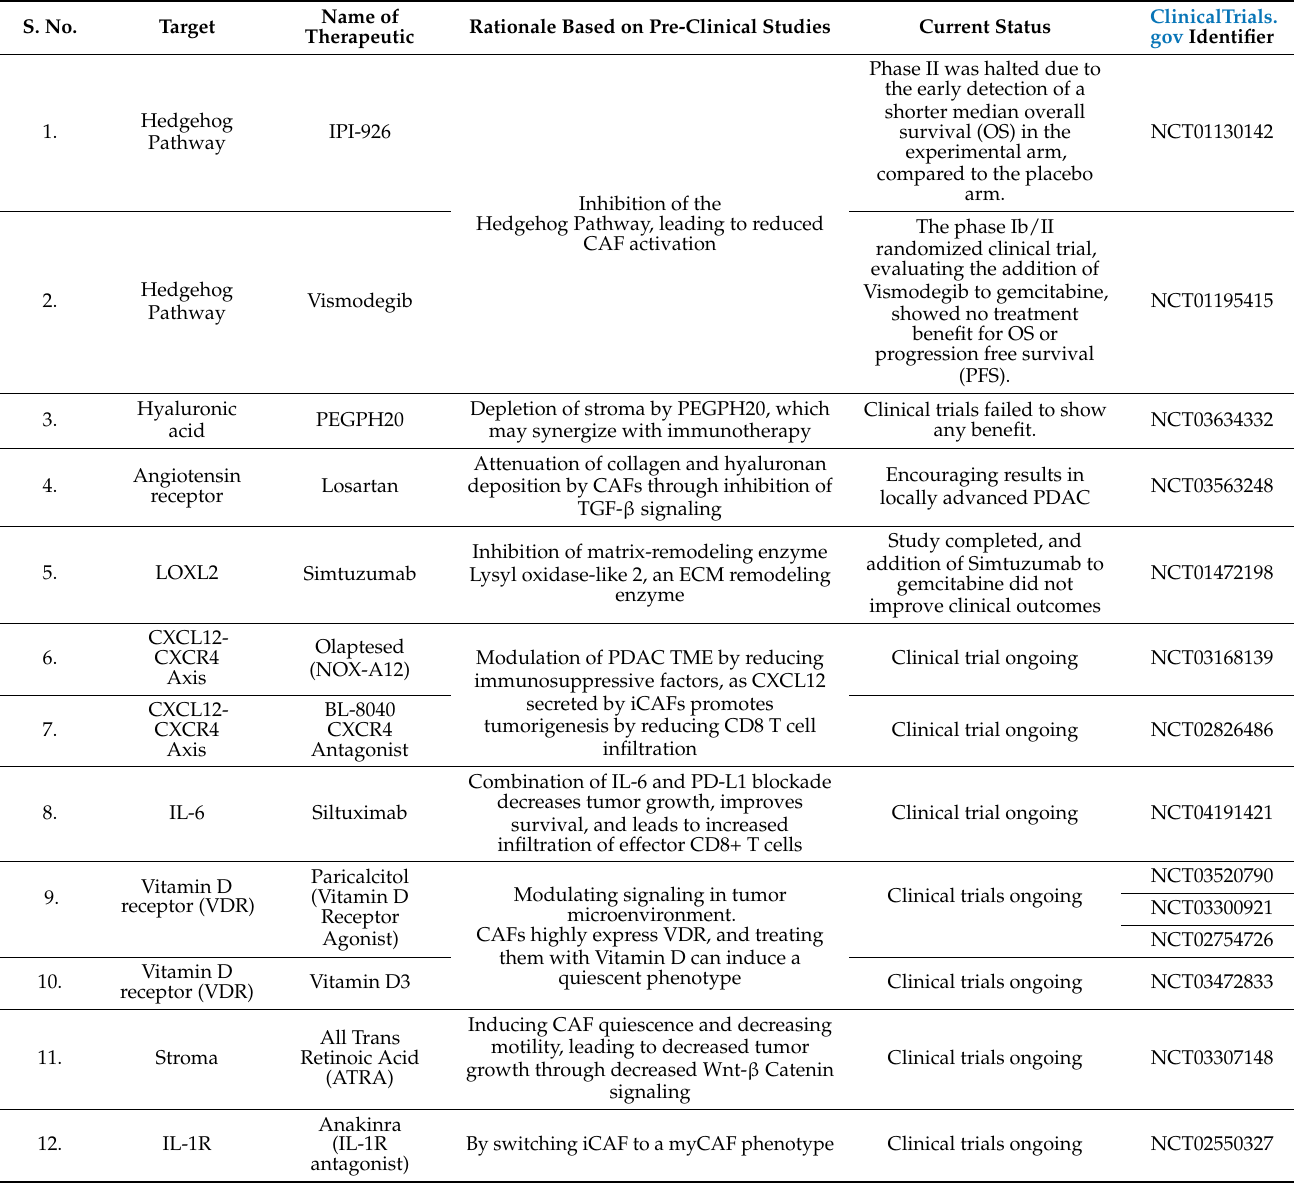
Table 1. Clinical trials targeting CAFs in